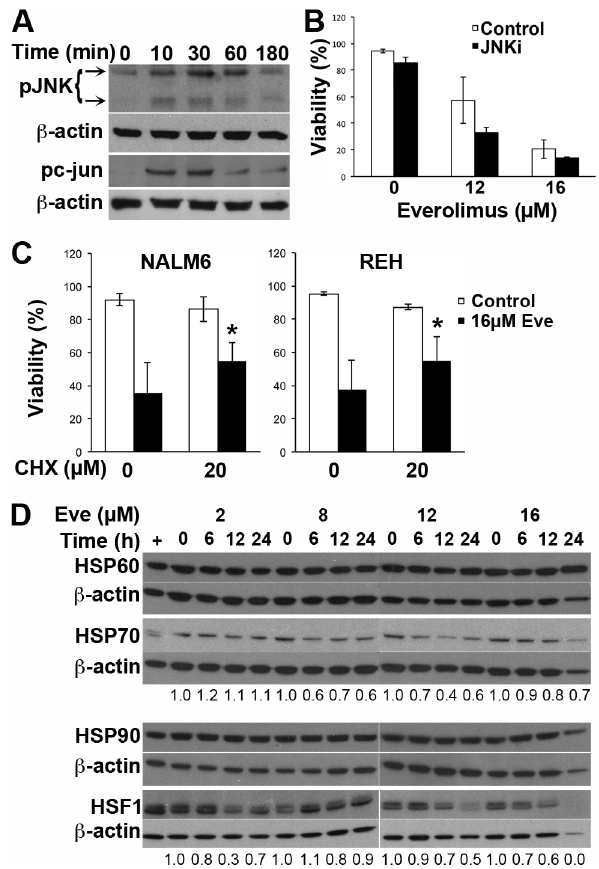
Figure 5. Cell death is dependent on new protein synthesis but not JNK signalling. ( A ) NALM6 cells were treated for the indicated time with 16 m M everolimus and cell lysates prepared. Lysates were probed for phosphorylated JNK (p-JNK) and loading assessed using b - actin. ( B ) NALM6 cells were treated with the indicated concentrations of everolimus for 16 h, with or without a 1 h pre-incubation with the